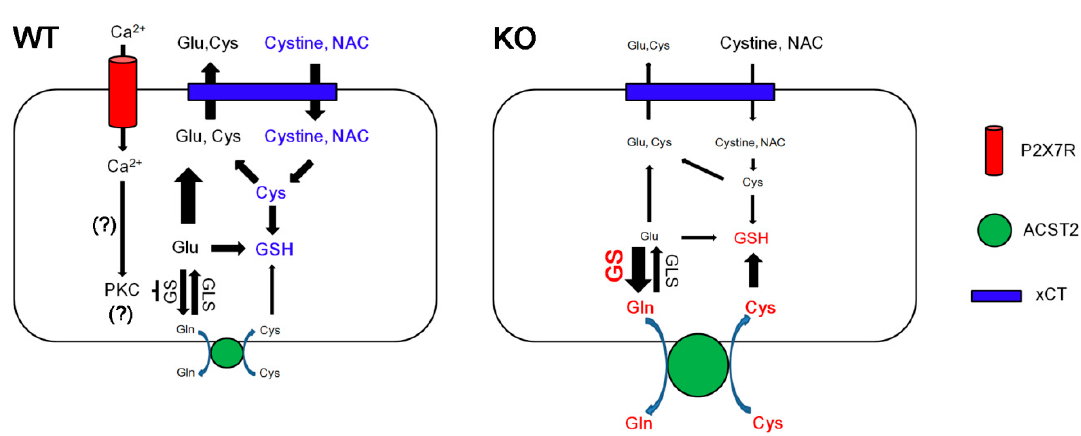
Figure 6. Scheme of roles of P2X7R in basal GSH levels based on the present data and a previous report [17]. Under physiological conditions, P2X7R activation increases Ca 2 + influx, which would inhibit GS expression by PKC activation without altering GLS expression. This mode of regulation maintains the yield of the glutamate (Glu)–glutamine (Gln) cycle and xCT-mediated uptake of cysteine (Cys) precursors such as cystine / NAC, which increases GSH level. However, P2X7R deletion leads to the upregulation of GS expression, which inhibits xCT activity due to reduced glutamate level. Instead, the elevated glutamine level accelerates ACST2-mediated glutamine–cysteine exchanges. The reductions in both glutamate and cystine levels diminish the GSH level.